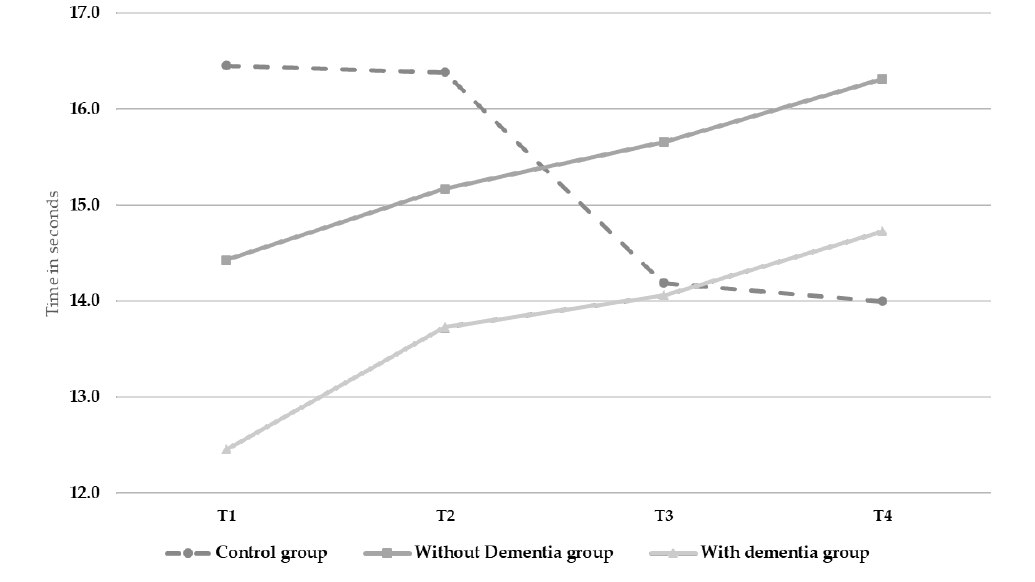
Figure 2. Changes in mobility (Tinetti test) over time . Table 2. Analysis of variance testing the effect of 1 year lifestyle intervention on all the outcome variables.